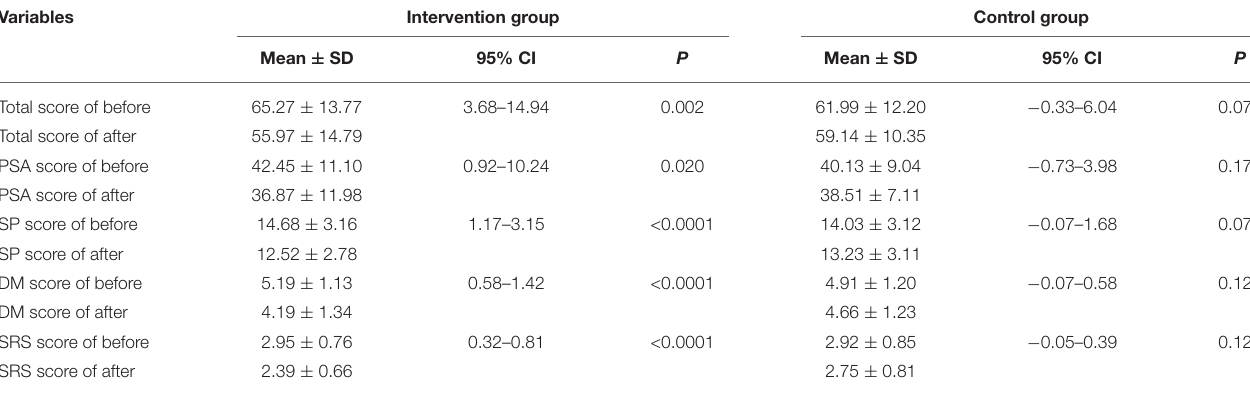
TABLE 3 | Total and subscales scores evaluated before and after 4 weeks of treatment in the intervention group and the control group. Variables